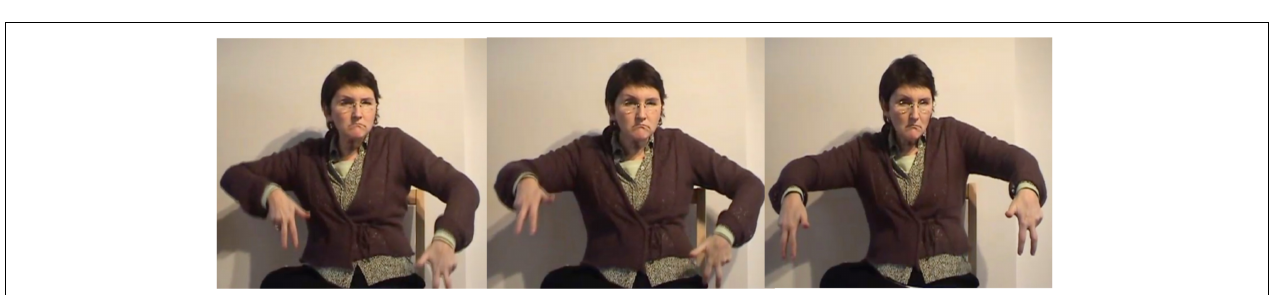
FIGURE 14 | Stretch of constructed action (CA: walking-deer), as produced in example 5.